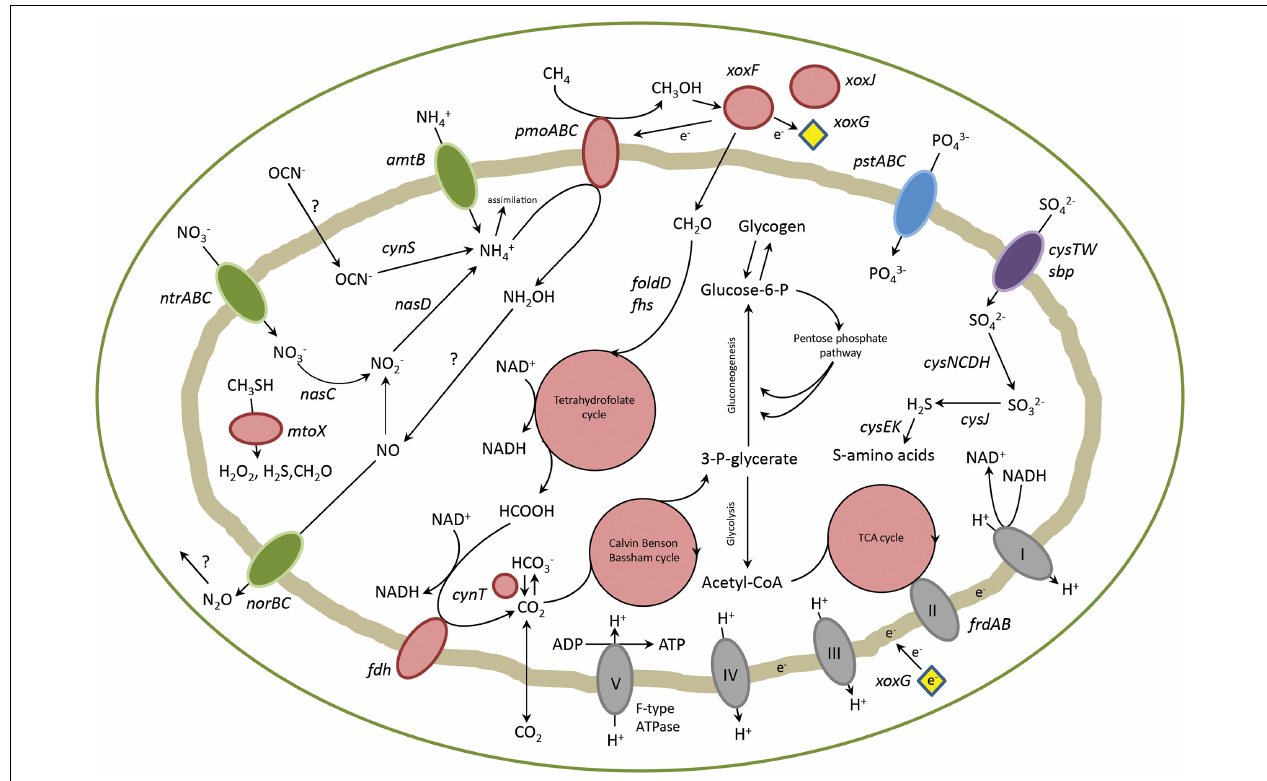
FIGURE 2 | Overview of metabolic pathways in “ Ca. M. pantelleriae.” Colors of enzymes and transporters indicate nitrogen metabolism (green), carbon metabolism (red), sulfate metabolism (purple), phosphate metabolism (blue) and complexes of the respiratory chain (gray). Genes: pmoABC , methane monoxygenase; xoxF , methanol dehydrogenase, xoxG , cytochrome c L ; xoxJ , periplasmic binding protein; folD , bifunctional 5,10-methylene-tetrahydrofolate dehydrogenase/5,10-methylene-tetrahydrofolate cyclohydrolase; fhs , formate-tetrahydrofolate ligase; fdh , formate dehydrogenase; cynT , carbonic anhydrase; frdAB , fumarate reductase; pstABC , phosphate transporter; cysTW/sbp , sulfate transporter; amtB , ammonia transporter; ntrABC , nitrate transporter; nasC , assimilatory nitrate reductase; nasD , assimilatory nitrite reductase; norBC, nitric oxide reductase; cynS, cyanase; cysCDH , adenylyl-sulfate kinase, sulfate adenylyltransferase, phosphoadenosine phosphosulfate reductase; cysJ , sulfite reductase; cysK , cysteine synthase; cysE , serine acetyltransferase; mtoX , methanethiol oxidase.